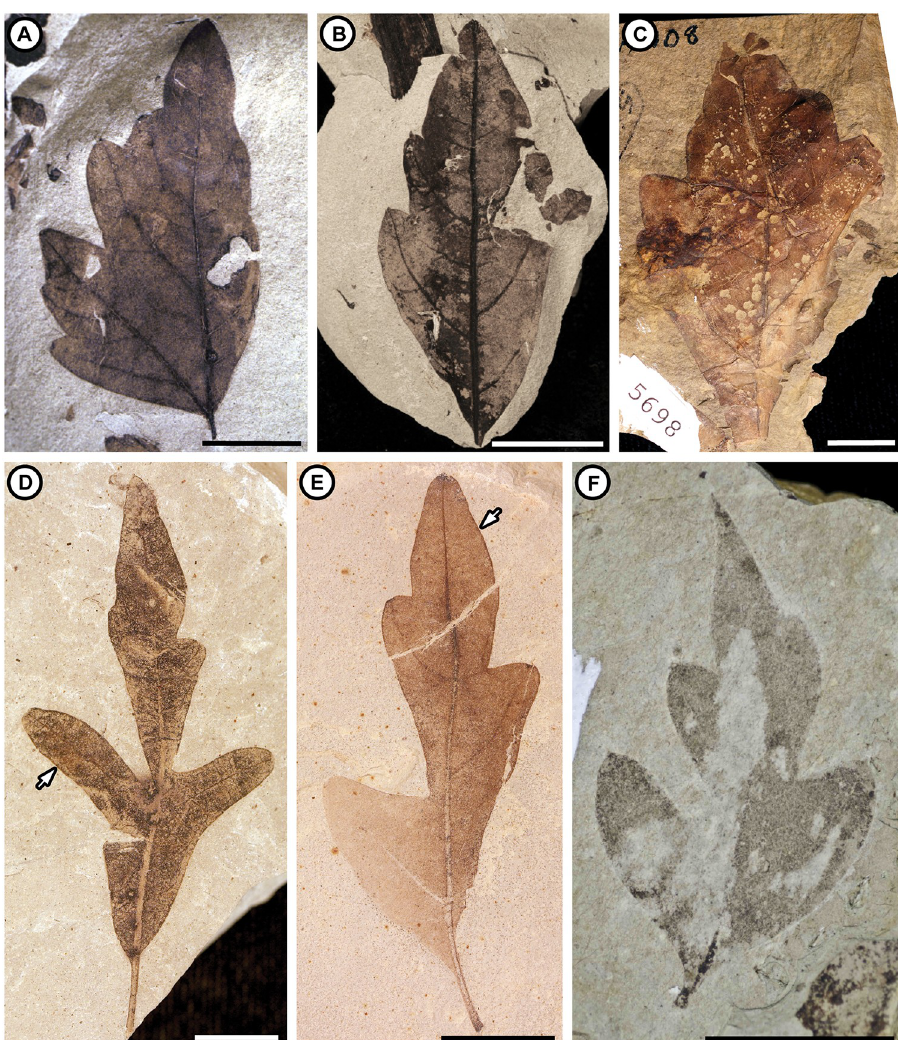
Fig 5. Leaf fossils previously assigned to Paullinieae. (A) “Serjania” rara MacGinitie from the Bridger Formation, Blue Rim site, Sweetwater County, Wyoming, UF 15761S-57786. (B) “Serjania” rara MacGinitie from the Bridger Formation, Blue Rim site, Sweetwater County, Wyoming, UF 15761N-61430. (C) Paratype of “Serjania” rara MacGinitie from the Aycross Formation, Kisinger Lakes site, northwestern Wyoming (Pl 25, Fig 3 in [74]), UCMP PA 108, 5698. (D) Hypotype of “Cardiospermum” coloradensis (Knowlton) MacGinitie from the Green River Formation, west of Wardell Ranch site, Colorado (Pl 22, Fig 3 in [81]), UCMP PA 321, 20593. Arrow indicates marginal vein. (E) “Cardiospermum” coloradensis (Knowlton) MacGinitie from the Green River Formation in Rainbow, UT, UCMP PB02016, 201265. Arrow indicates marginal vein. (F) “Cardiospermum” terminale (Lesquereux) MacGinitie from the Florissant Formation in central Colorado, FLFO 10147. Scale bars = 1